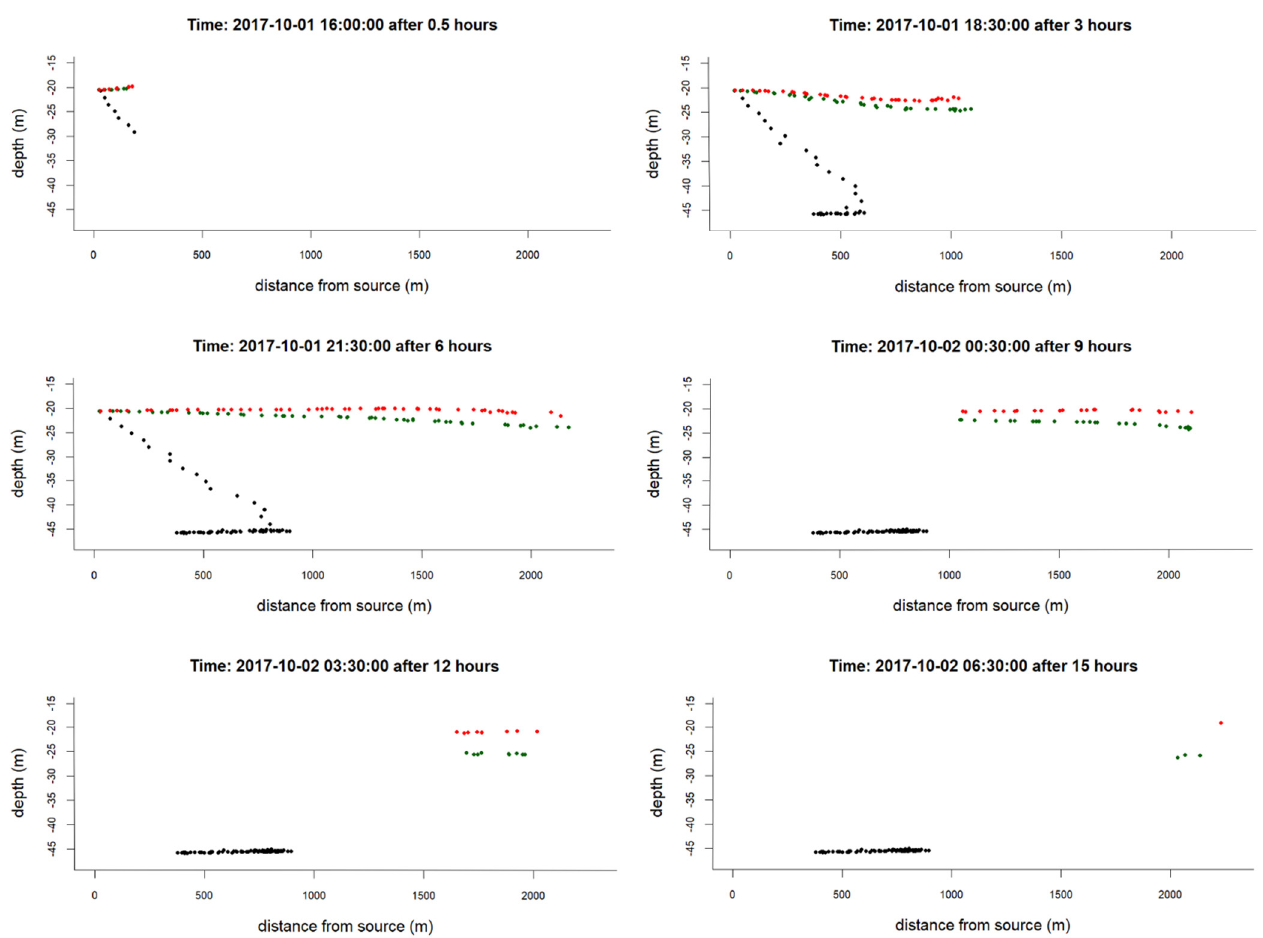
Figure 17. Plt B vertical cross section of PW discharged, trajectories and deposition on the seabed of PW suspended particulate matter (clay—red line, silt—green line, sand—black line) during a continuous discharge event (every 3 h from 1 October 2010 16:00 to 2 October 2010 06:30 by MIKE 3 PT module output). Discharge point at the upper left corner of the figure.